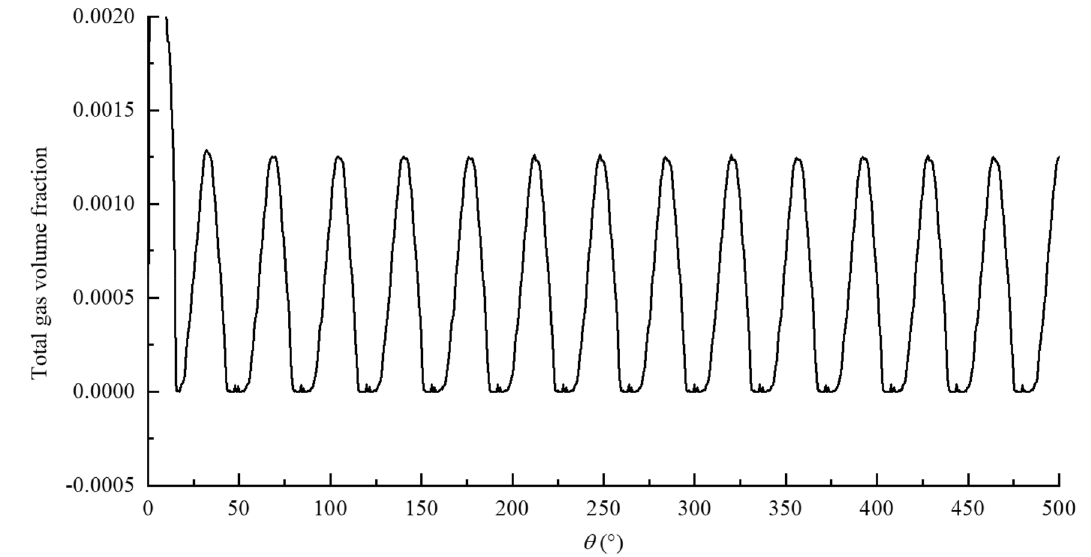
Figure 18. The variation of total gas volume fraction in rotor region with rotation